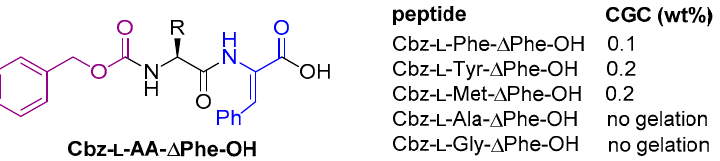
Figure 7. Summary of carboxybenzyl-capped peptides capable of forming hydrogels.